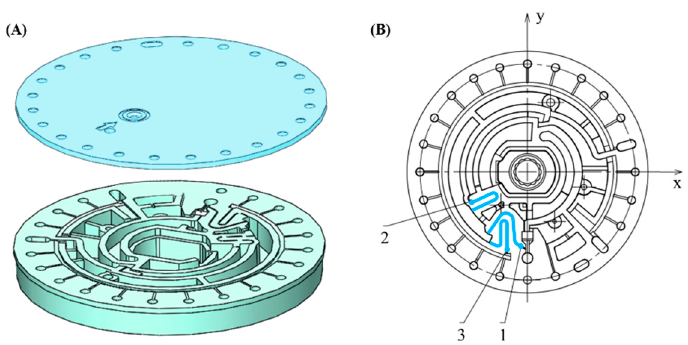
Figure 2. ( A ) Three-dimensional pictures of the chip lid and chip substrate; ( B ) layout of the chip substrate made up of different microchannels and microchambers in which 1, 2, 3 refer to the first, second and third siphon valve, respectively.